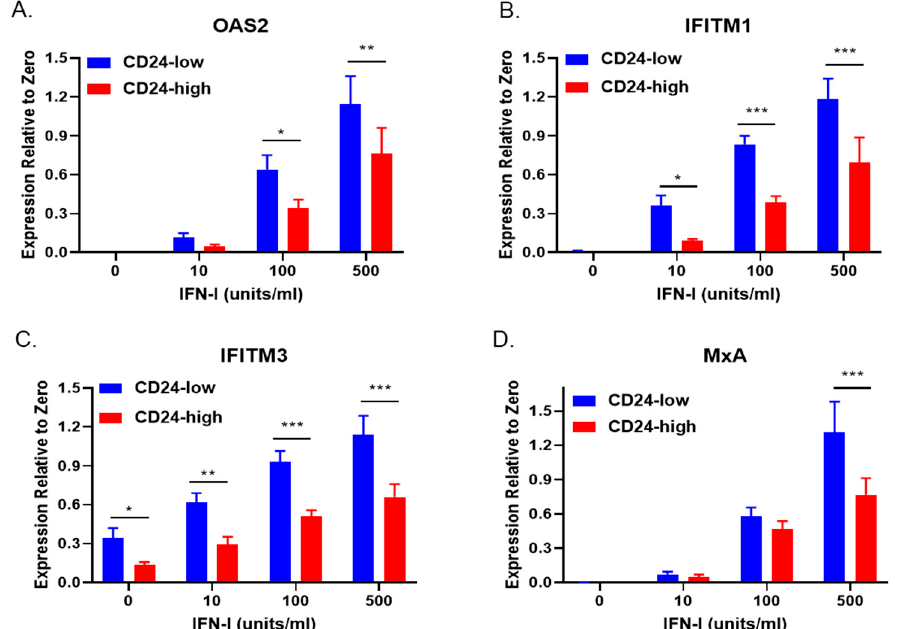
Figure 3. CD24-low and -high cells differ in ISG expression in response to IFN-I stimulation. CD24-low and -high cells were stimulated with the indicated concentrations of IFN-I for 16 h. Total cellular RNA was isolated, and levels of ISGs OAS2 ( A ), IFITM1 ( B ), IFITM3 ( C ), and MxA ( D ) were determined by qRT-PCR. Data are expressed as basal gene levels (Expression Relative to Zero). Values are the mean of three samples, with error bars representing standard deviation. *, **, and *** indicate p -values <0.033, <0.002, and <0.001, respectively.